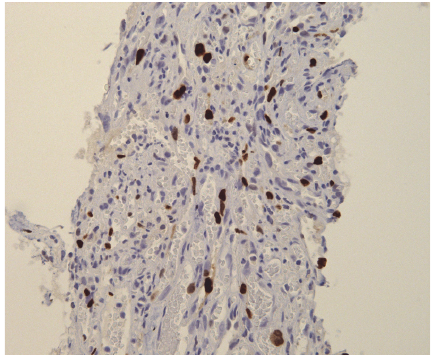
Figure 6: Pulmonary metastasis of splenic angiosarcoma. Immuno- histochemical MIB1 staining. 20-fold